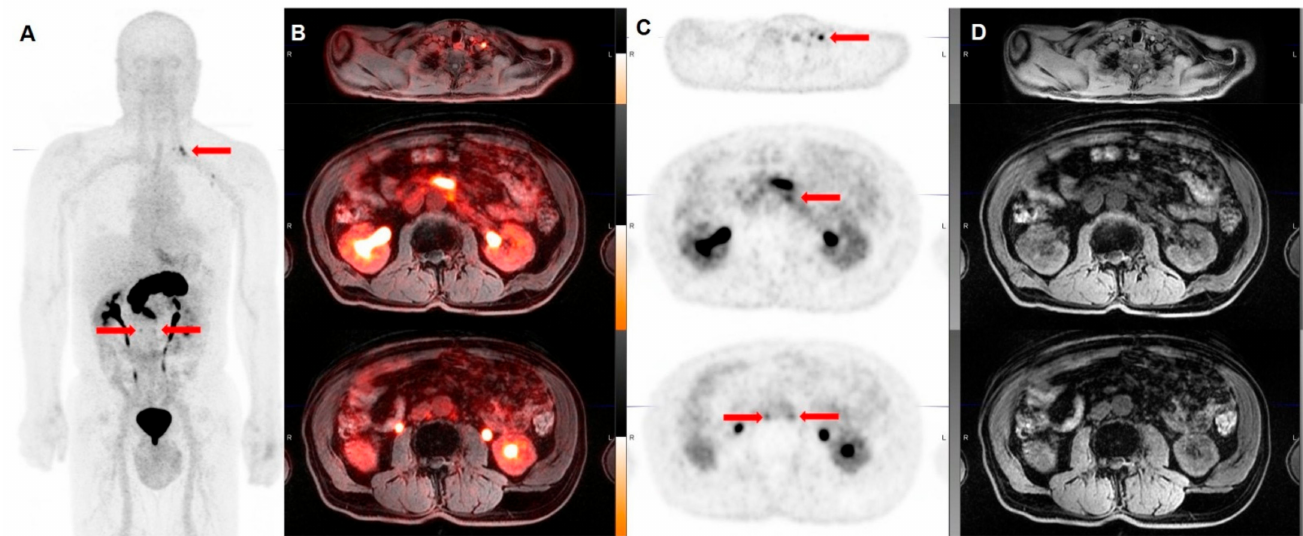
Figure 3. Whole body Maximum Intensity Projection (MIP, A ), fused coronal 68 Ga-RM2-PET/MRI ( B ), coronal emissive 68 Ga-RM2-PET ( C ), and MRI images ( D ) in a 74 year-old man with PCa in biochemical recurrence (PSA 8.4 ng/mL). Focal 68Ga-RM2 uptake is seen in left supraclavicular and retroperitoneal lymph nodes (red arrows). (Images courtesy of Andrei Iagaru, MD, Stanford University).